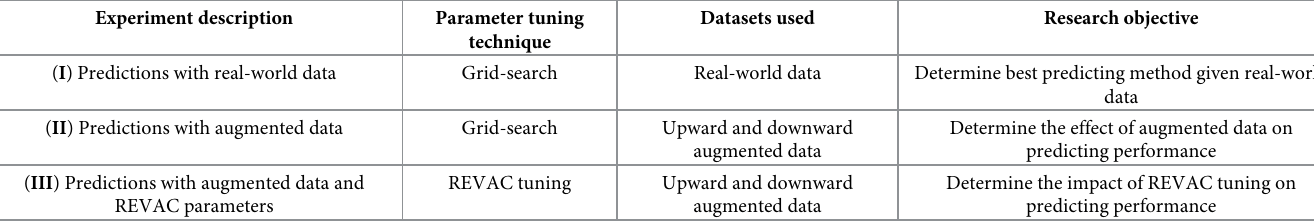
Table 2. Experiments